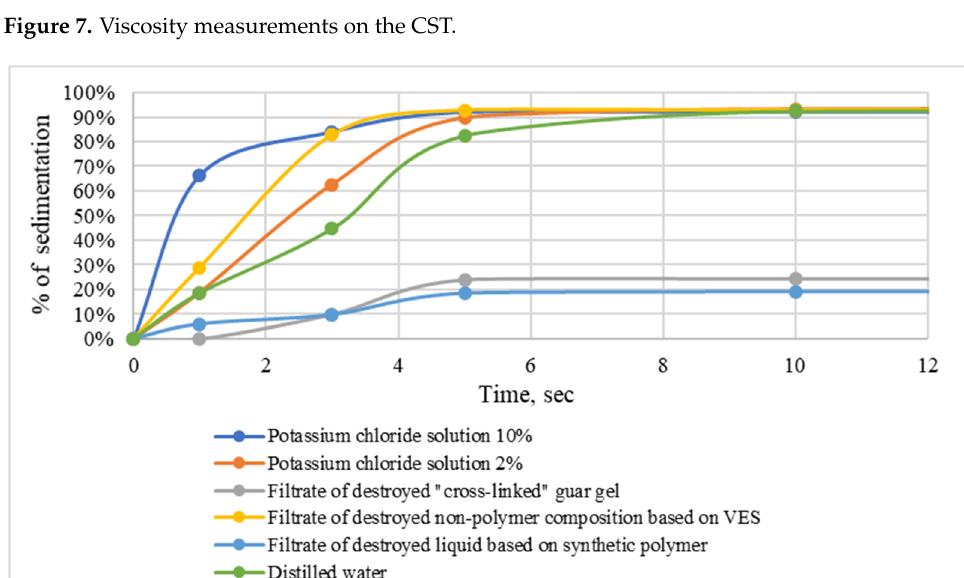
Figure 8. Results of the visual assessment of suspension stability. Dependence of the percentage of suspension sedimentation on time.